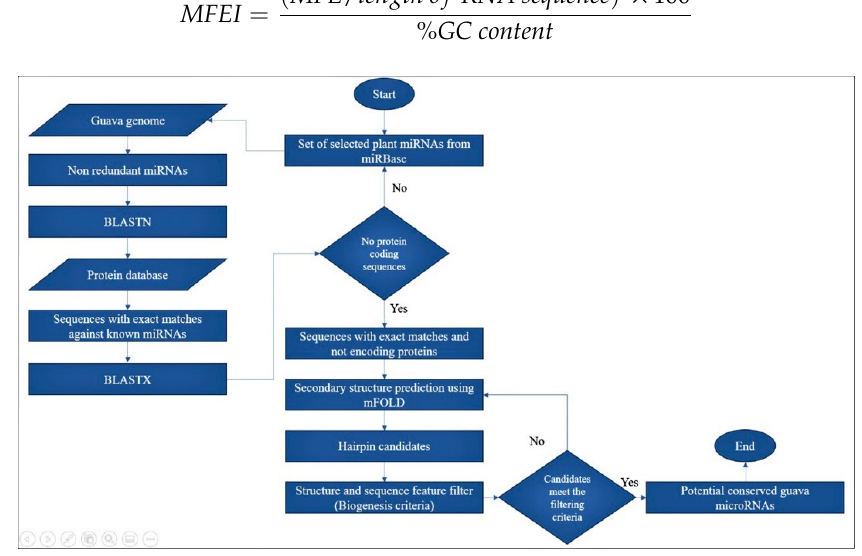
Figure 1. Diagrammatic representation of guava miRNA search procedure (workflow).